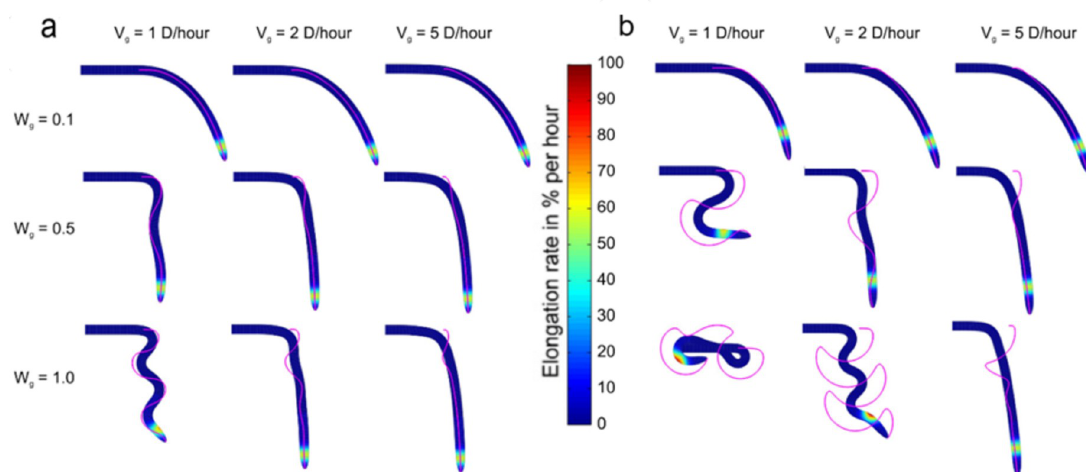
Fig 4. Effects of signal speed, sensitivity, and zonation on root growth. Two different root zonation peaks are compared (in colored scale, where red represents the location of maximum response): (a) the peak of the growth rate (%) is located at a distance of 1.5 times the average diameter of the formed root ( d = 1.5 D ) from the tip; (b) the peak of the growth rate (%) is located at a distance of d = 3.0 D from the tip. All the roots present the result after 16 h of gravitropic stimulations with a different propagation speed ( v ( w g ). Magenta lines depict the trajectories of the tip. Colors show the rate (%) of elongation per h.